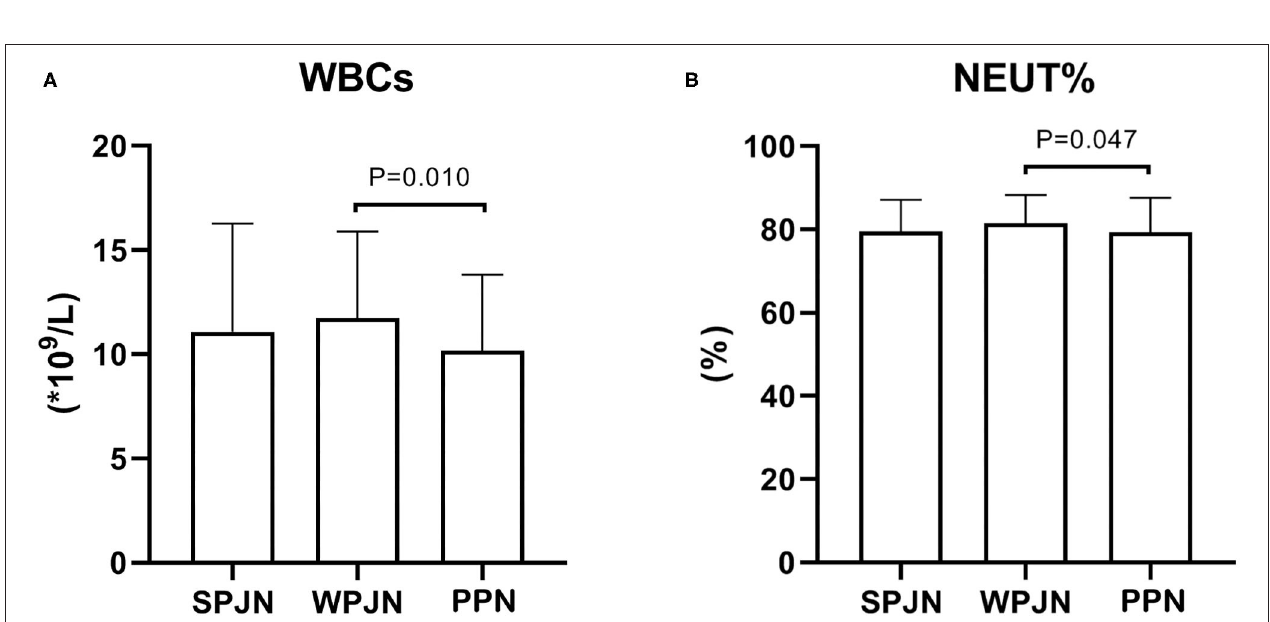
FIGURE 3 | Inflammatory response indexes. The WBCs and lymphocyte percentage (LYM %) after operation were significantly lower in the PPN compared to the WPJN group (A,B) .